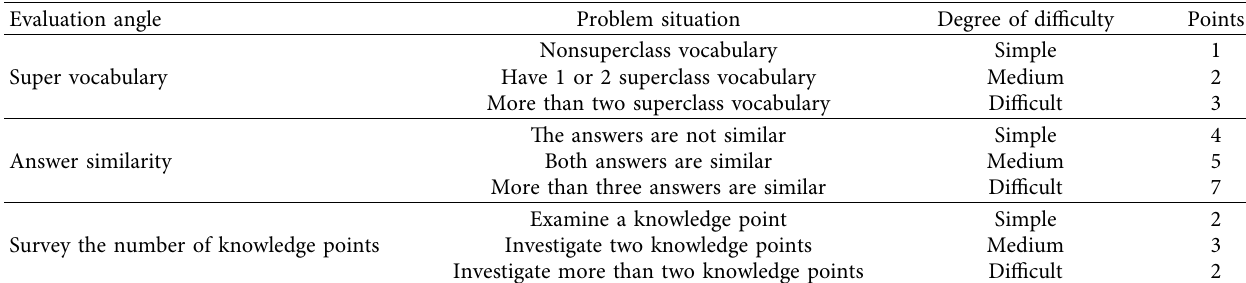
Table 1: Difficulty and ease of